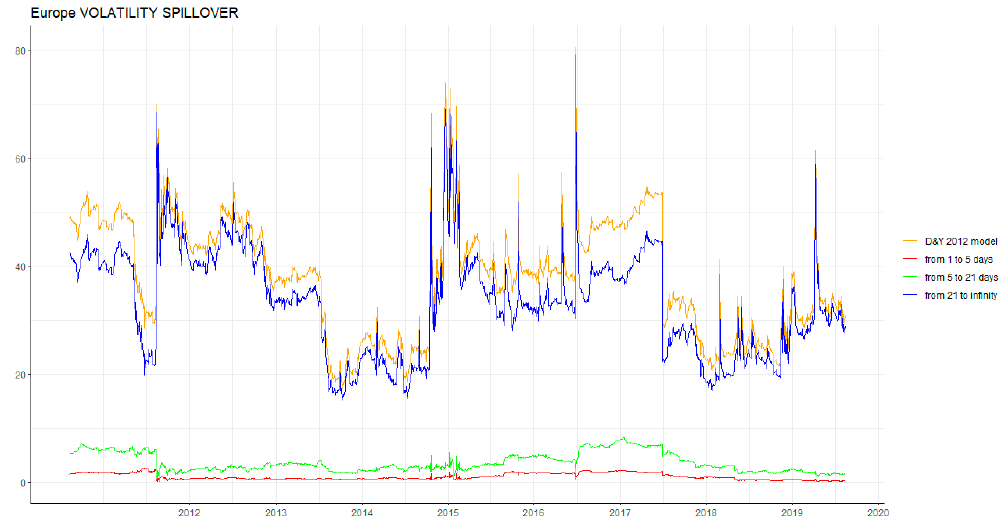
Figure A11. Total volatility spillover of DY12 and BK18 in Europe (Windows 250).